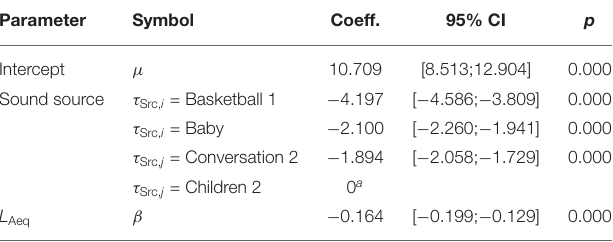
TABLE 5 | Experiment 2: model coefficients (Coeff.), their 95% CI, and probabilities ( p ) of the linear mixed-effects model for acoustic comfort. Parameter Symbol Coeff. 95% CI Intercept